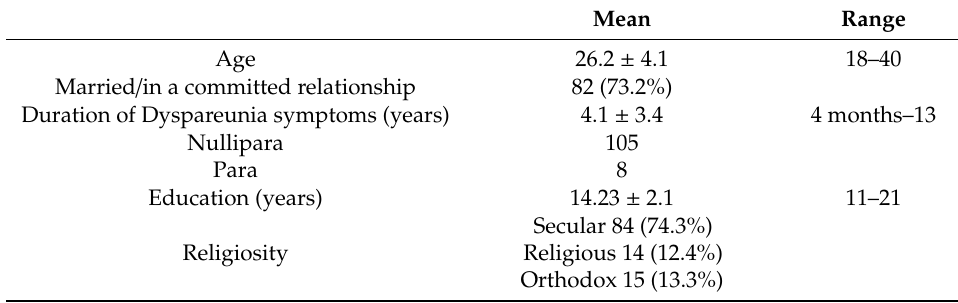
Table 1. Sociodemographic characteristics of the study